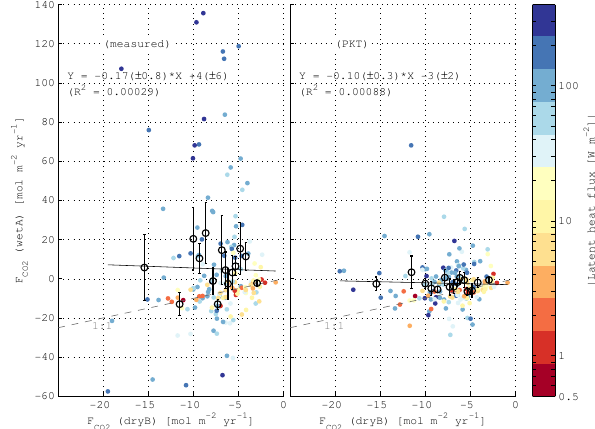
Fig. 4. Time series of the bias fluxes in Eq. 3, caused by air density fluctuations (Webb et al., 1980). Top: bias flux caused by humidity fluctuations F q upstream of the dryer wet and downstream dry and the CO 2 flux F c as measured by the IRGA dry (there are only small differences between A and B ). Bottom: bias flux caused by temper- ature fluctuations F T as measured by the bow mast sonic and as measured by the CP IRGAs, and the bias flux caused by pressure fluctuations F P .